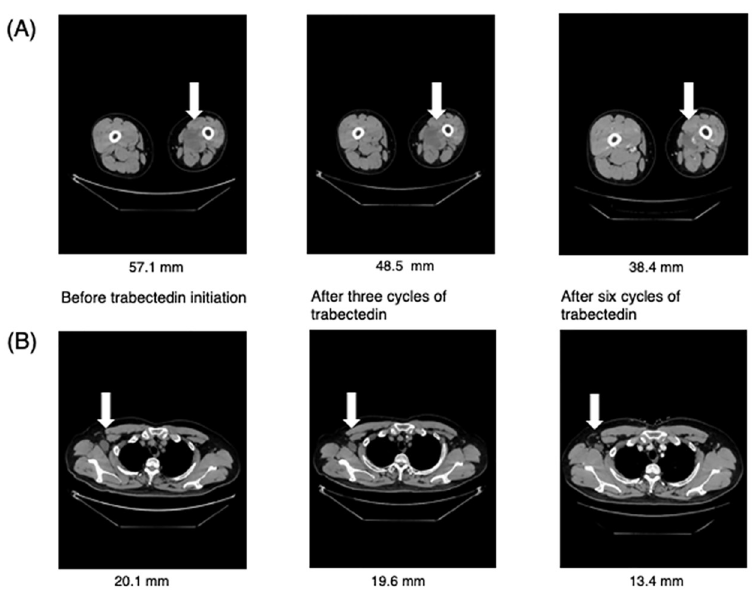
Fig 2. Radiological response following three and six cycles of trabectedin in patient ID-4. Lesions in the left thigh ( A ) and right axillary lymph node ( B ) are presented in the following order (left column, before trabectedin initiation; middle column, after three cycles of trabectedin; right column, after six cycles of trabectedin). The length of the left thigh lesion and the breadth of the right axillary lymph node are shown.